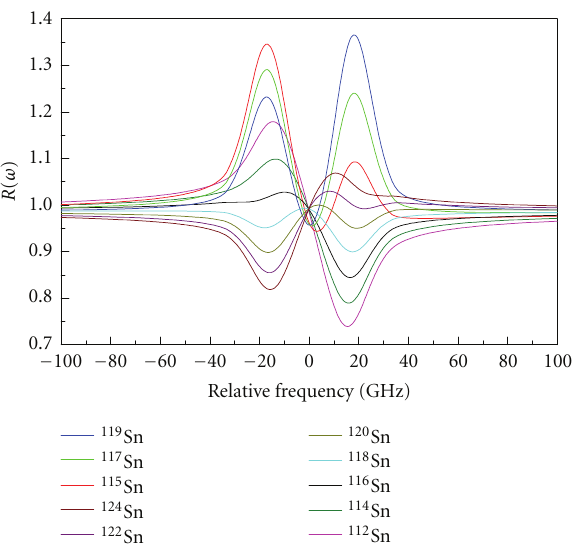
Figure 2: Response of the Snisotopes as afunction of laser detuning for the 5p 2 3 P 0 − 5p 6s ( 3 P 0 ) (286.3317nm ) transition for a laser 1 linewidth of 15 GHz and a Doppler width of 2 GHz.